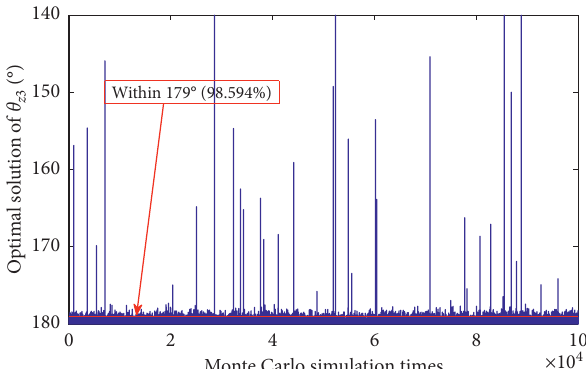
Figure 9: The distribution of the genetic optimization results for a rotor at the 3rd